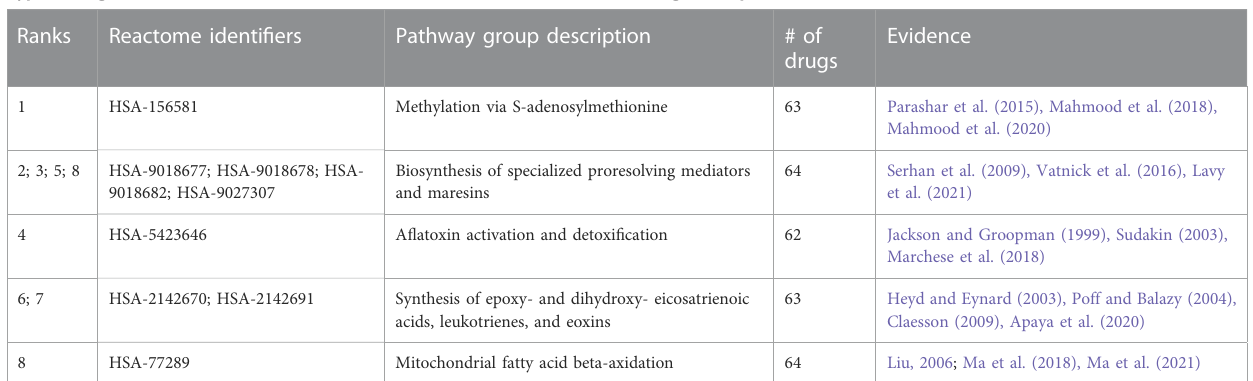
TABLE 2 Pathways most important for predicting Neoplasm Metastasis. Pathway importance as extracted from random forest models trained on drugs known to treat the Neoplasm Metastasis class are listed. The models for this indication, which had 68 drugs associated, achieved an average accuracy of 0.76 across 10 iterations of training with a random 90% of the associated drugs as positive samples and testing with the remaining 10% (including an equal number of randomly selected “ negative ” training/test samples from the rest of the drug library). The ranks of each pathway belonging to each group, their Reactome identi fi ers,andencompassingdescriptionofeachgrouparelistedaccompanied byliteraturereferencessupportingtheirimportanceincancer.Allpathwayshave multiple studies supporting their relevance, indicating these antineoplastic drugs may be exerting their therapeutic effects via these pathways, serving as a hypothesis generation tool for further validation and also for further multiscale drug